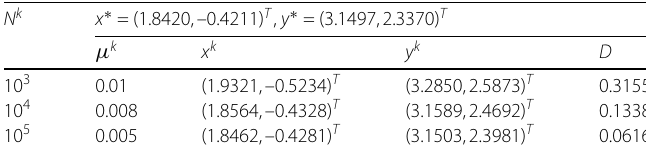
Table 2 Computational results for Example